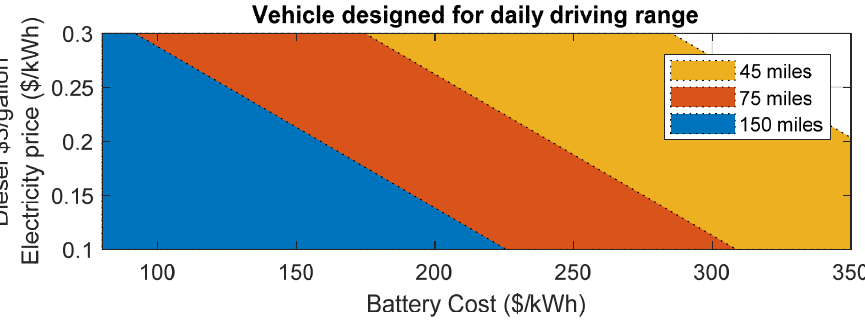
Figure 7. TCO parity check for class4 delivery truck with reduced VMT and resized battery pack.